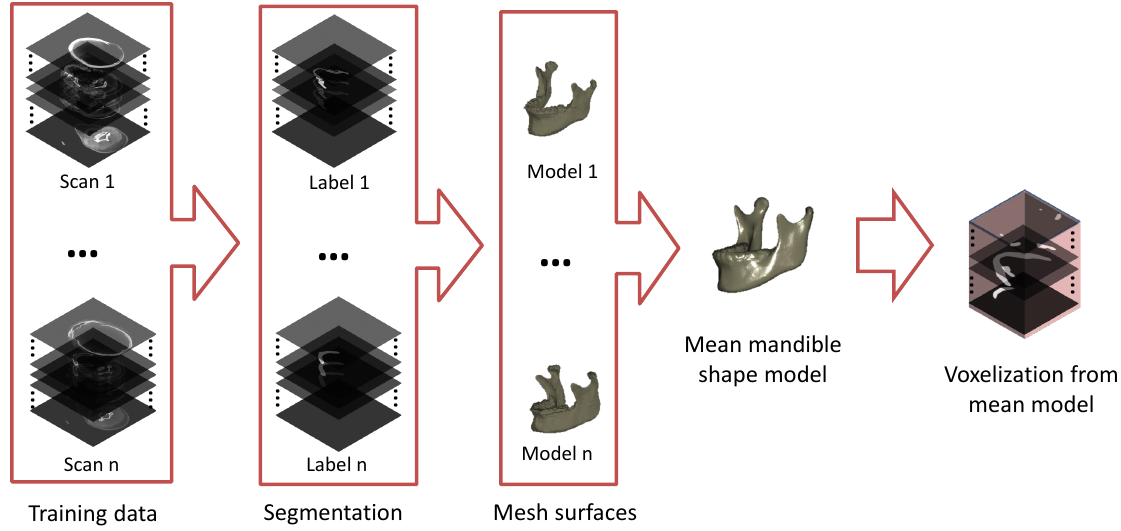
Figure 4. The procedure of generation of the mean mandible shape model. The generation consists of preparing the mandible model, generating the mesh surfaces, creating the mean mandible shape model, and calculating the corresponding mask